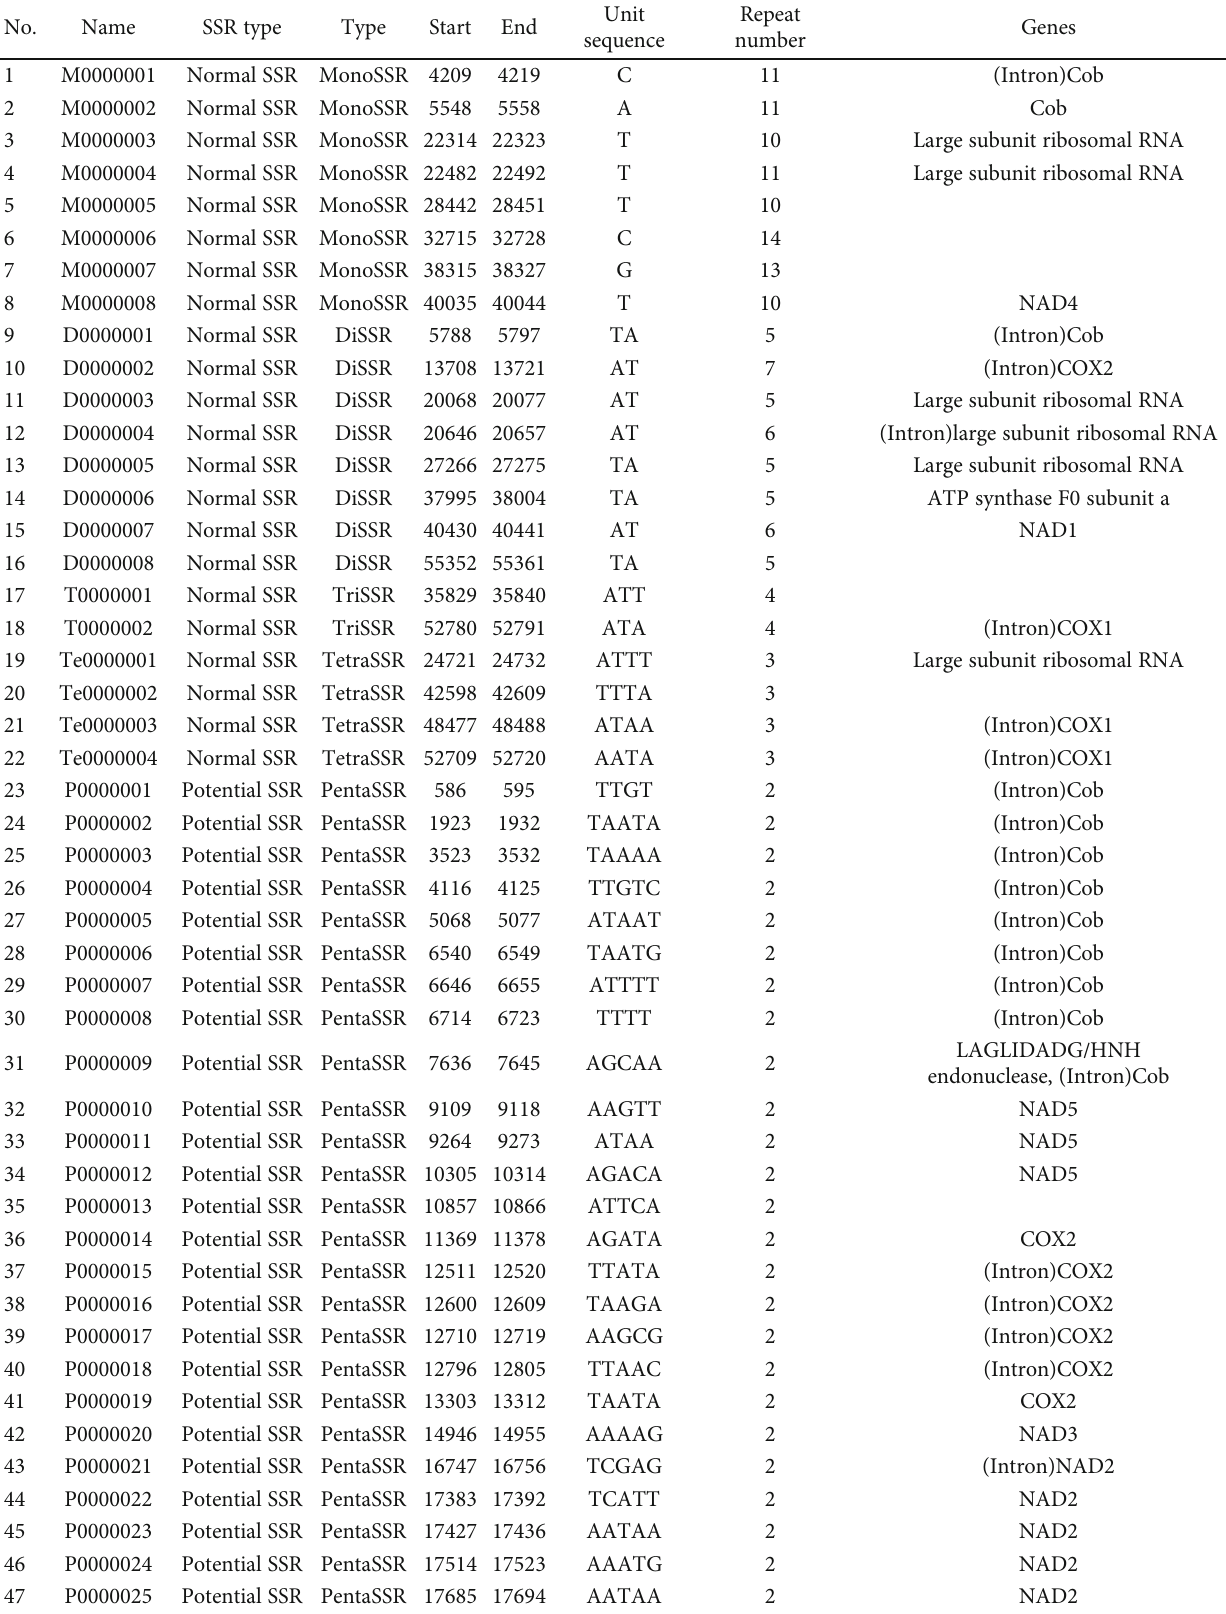
Table 7: List of SSRs identi fi ed on fungal endosymbiont mitogenome of WBPH KR.